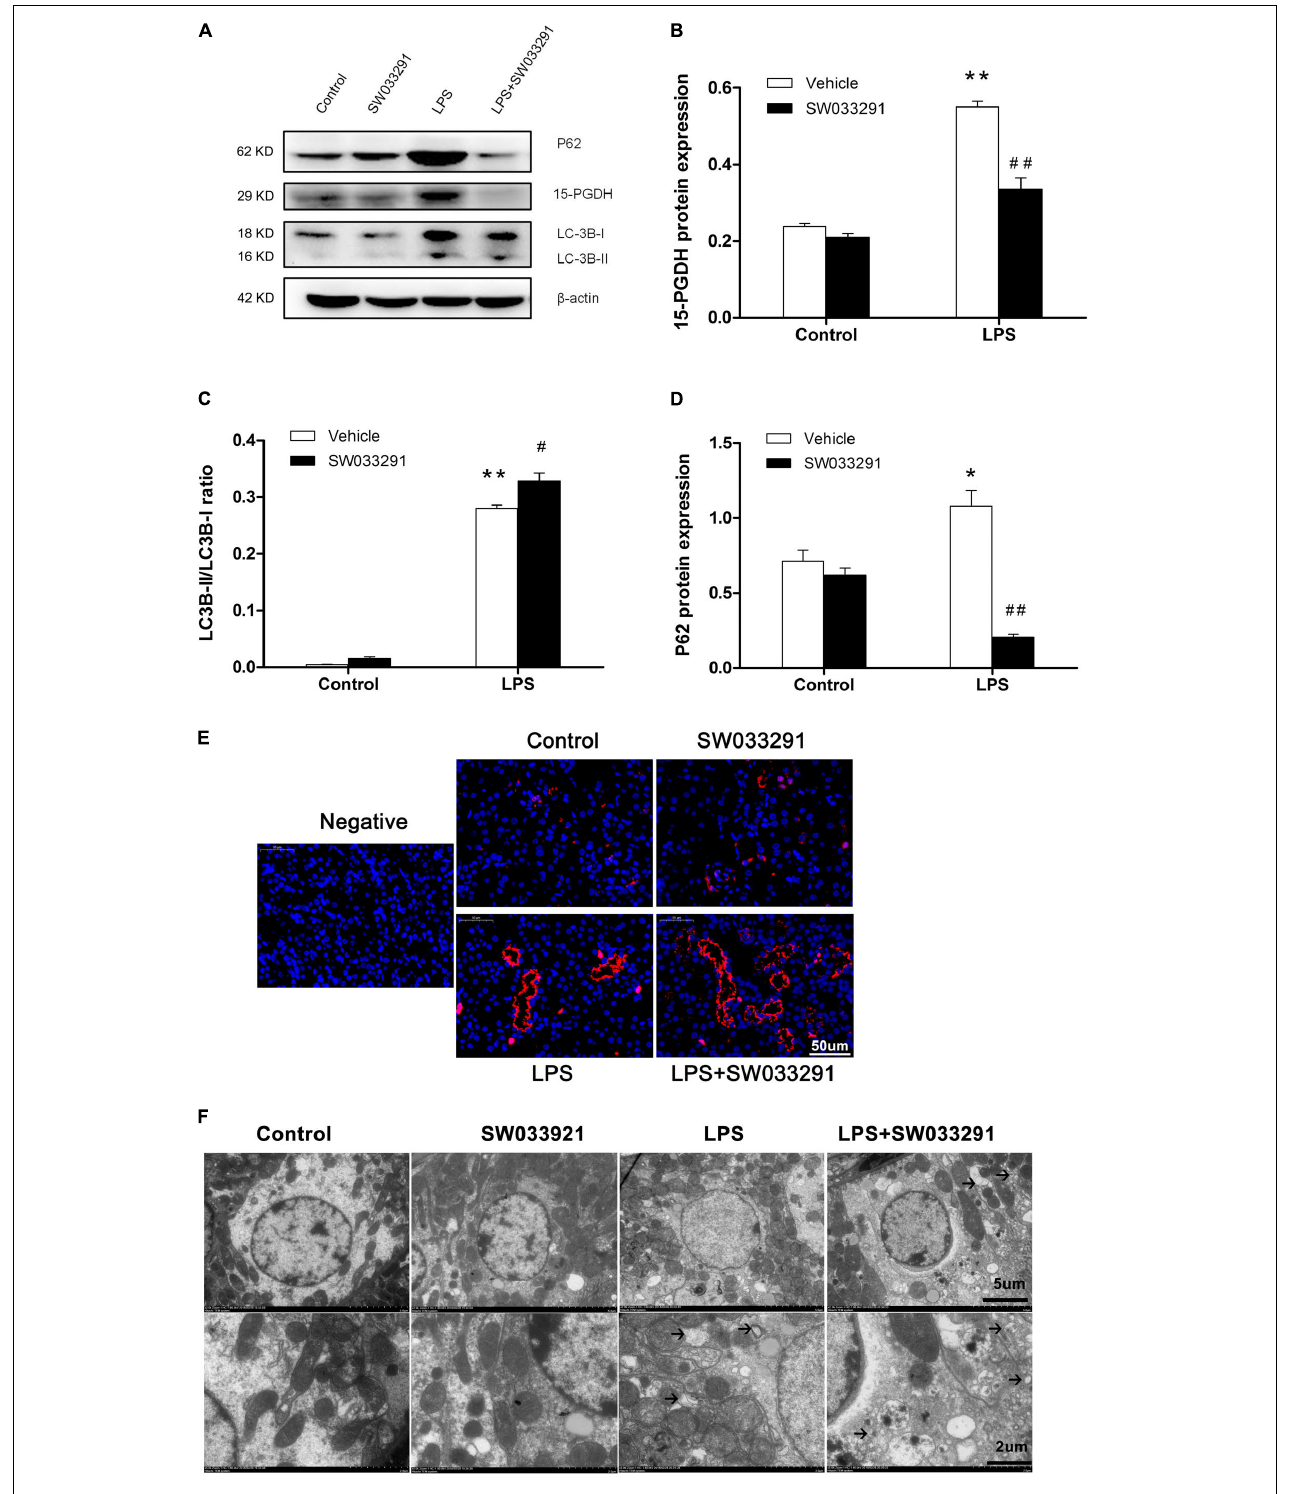
FIGURE 6 | Effect of SW033291 treatment on autophagic response in kidneys of LPS-induced AKI mice. (A) Western blotting was used to detect the protein expression of 15-PGDH, LC3B, and P62 in kidney tissues. (B) Density ratio of 15-PGDH/ β -actin in each group. (C) Density ratio of LC3-II/LC3-I in each group. (D) Density ratio of P62/ β -actin in each group. * P < 0.05, ** P < 0.01 vs. CON; # P < 0.05, ## P < 0.01 vs. LPS ( n = 3). (E) Immunofluorescence analysis of kidney tissue from LPS-induced mice with or without SW033291 (10 mg/kg) treatment shows localization of LC3B. Scale bars: 50 µ m, 400 × ( n = 3). (F) Autophagy level on renal tissue after SW033291 (10 mg/kg) treatment was observed by transmission electron microscope ( n = 3). Autolysosomes indicated by arrowheads. Scale bars: 5 µ m, 2 µ m. Data are mean ± SD.